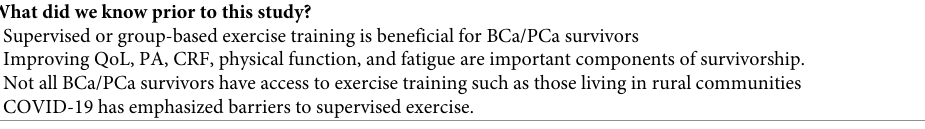
Table 2. Summary of implications found including current state of knowledge, new findings, and future direc- tions of study. What did we know prior to this study? • Supervised or group-based exercise training is beneficial for BCa/PCa